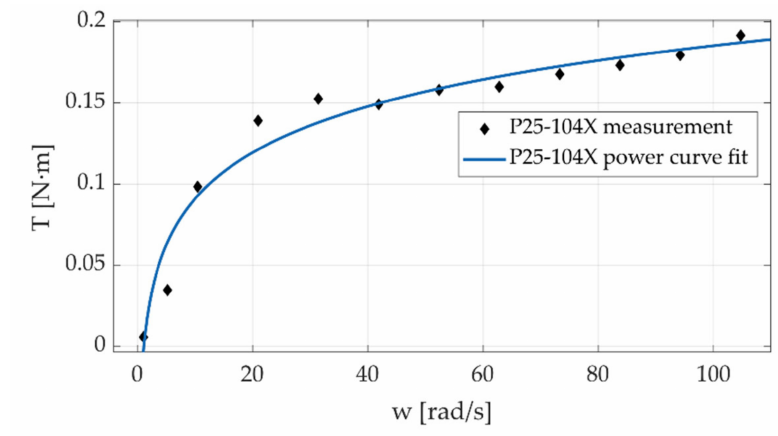
Figure 20. Friction torque of the cable-driven transmission 25–104 X.